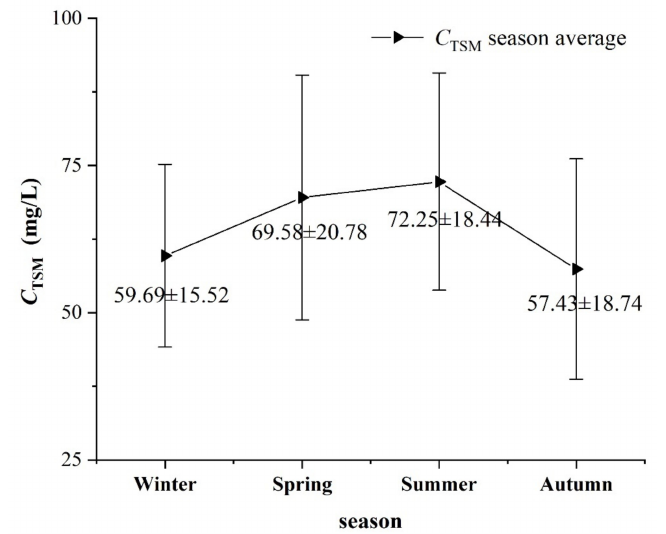
Figure 10. Average and standard deviation of TSM concentration in Changdang Lake in four